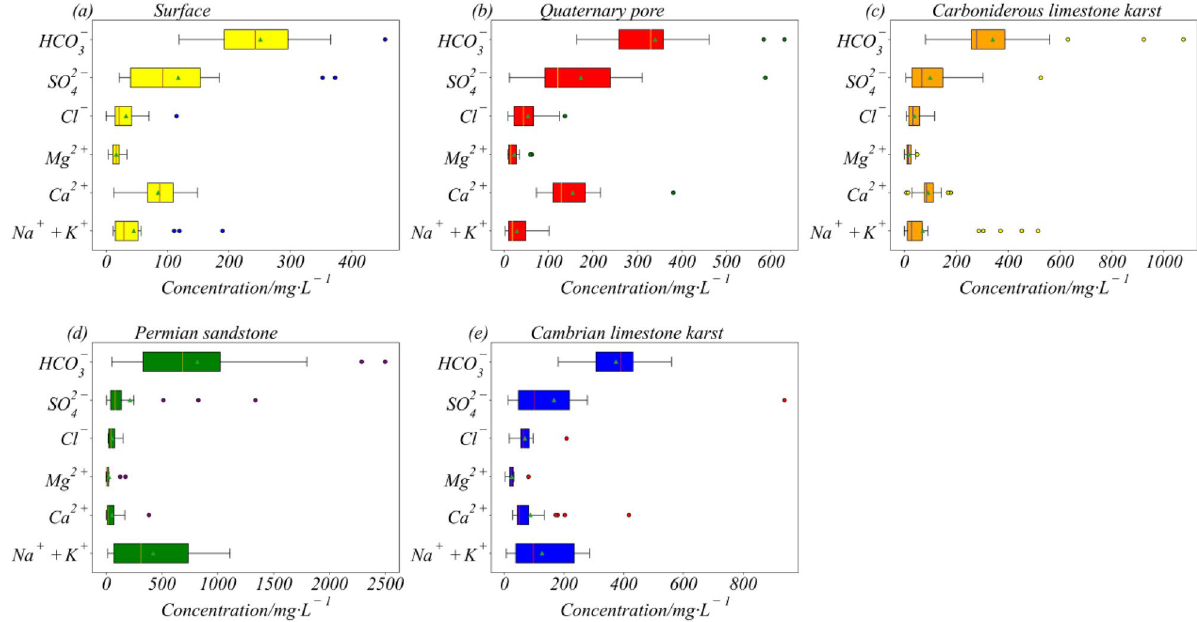
Figure 3. Boxplots of major hydrochemical parameters for different aquifers.